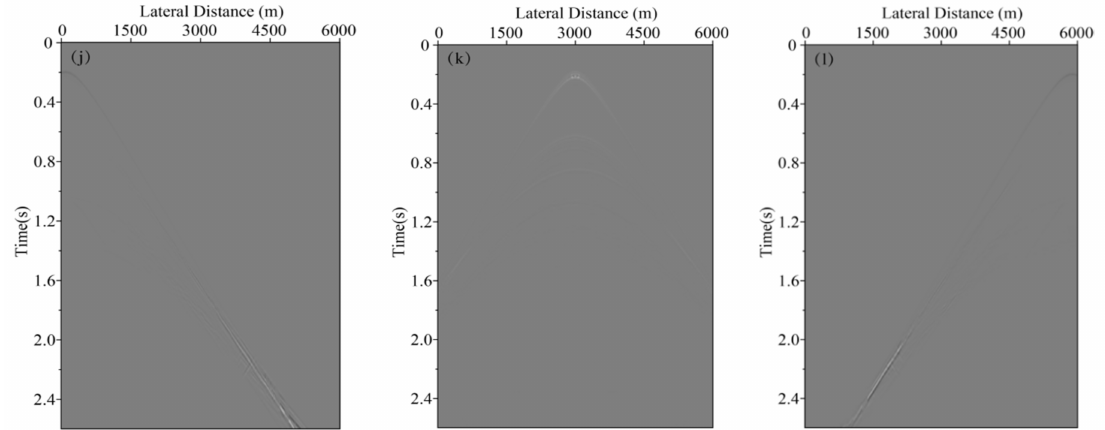
Figure 13. Shot record with internal multiple elimination using deep learning. ( a ) The 10th shot record with internal multiples. ( b ) The 300th shot record with internal multiples. ( c ) The 590th shot record with internal multiples. ( d ) The 10th shot record without internal multiples. ( e ) 300th shot record without internal multiples. ( f ) The 590th shot record without internal multiples. ( g ) The 10th shot record with internal multiple elimination using deep learning. ( h ) The 300th shot record with internal multiple elimination using deep learning. ( i ) The 590th shot record with internal multiple elimination using deep learning. ( j ) The difference between ( d ) and ( g ). ( k )The difference between ( e ) and ( h ). ( l ) The difference between ( f ) and ( i ).